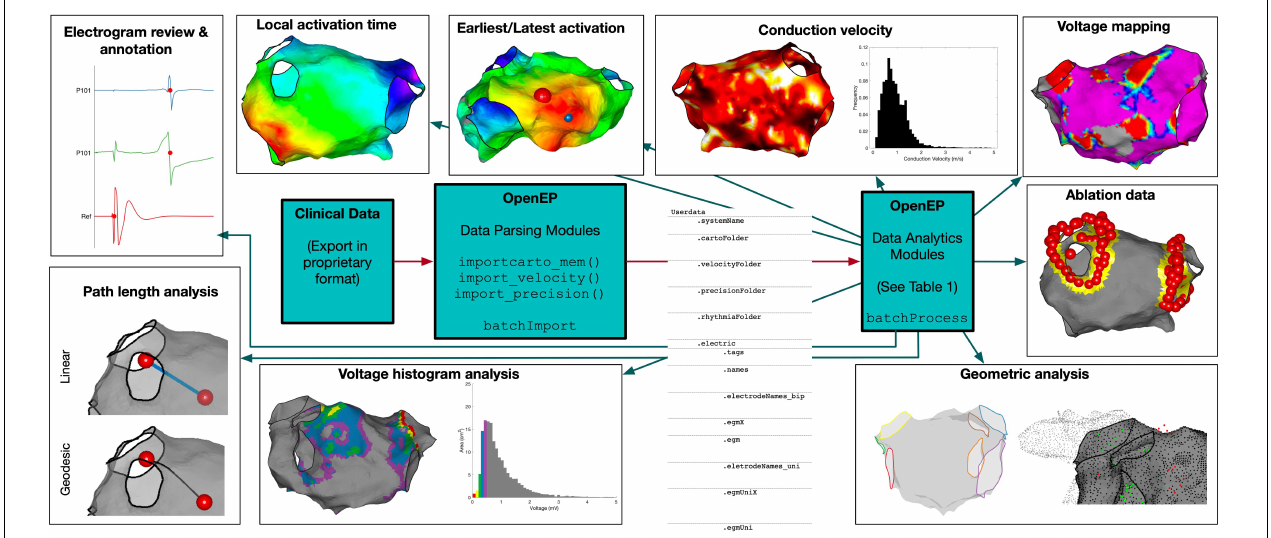
FIGURE 1 | OpenEP Overview. The core components of OpenEP are the data parsing modules (used to parse data from proprietary clinical system formats) and the data analytics modules (used to access and analyze the data stored in OpenEP